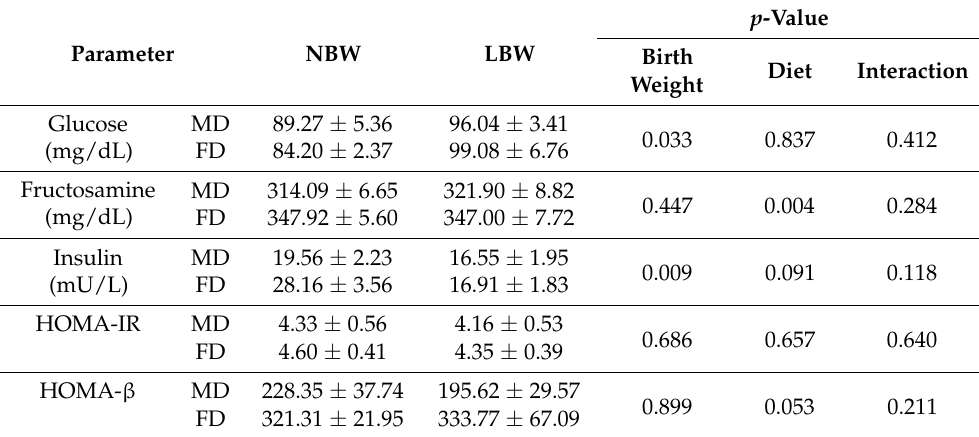
Table 2. Mean ( ± S.E.M.) and p -values of plasma concentrations for parameters of glucose metabolism, at 385 days-old, in female and male pigs with normal or low birth-weight (NBW and LBW, respec- tively) and fed with maintenance or fattening diets (MD and FD,